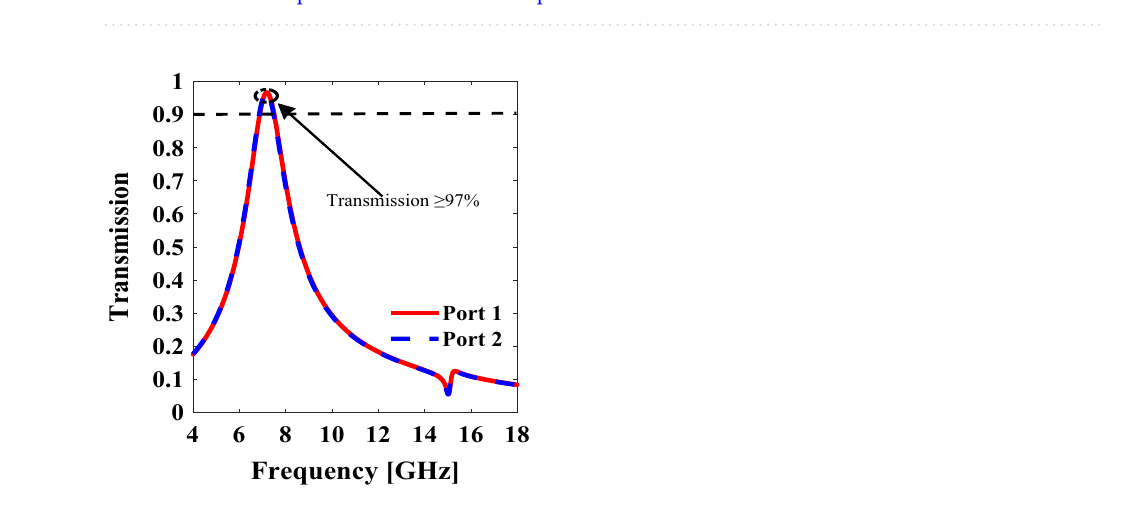
Figure 7. Absorption from port 1 for both x-polarized and y-polarized. *The figure is created using MATLAB ver. R2020A-URL: https:// www. mathw orks. com/ produ cts/ matlab. html.